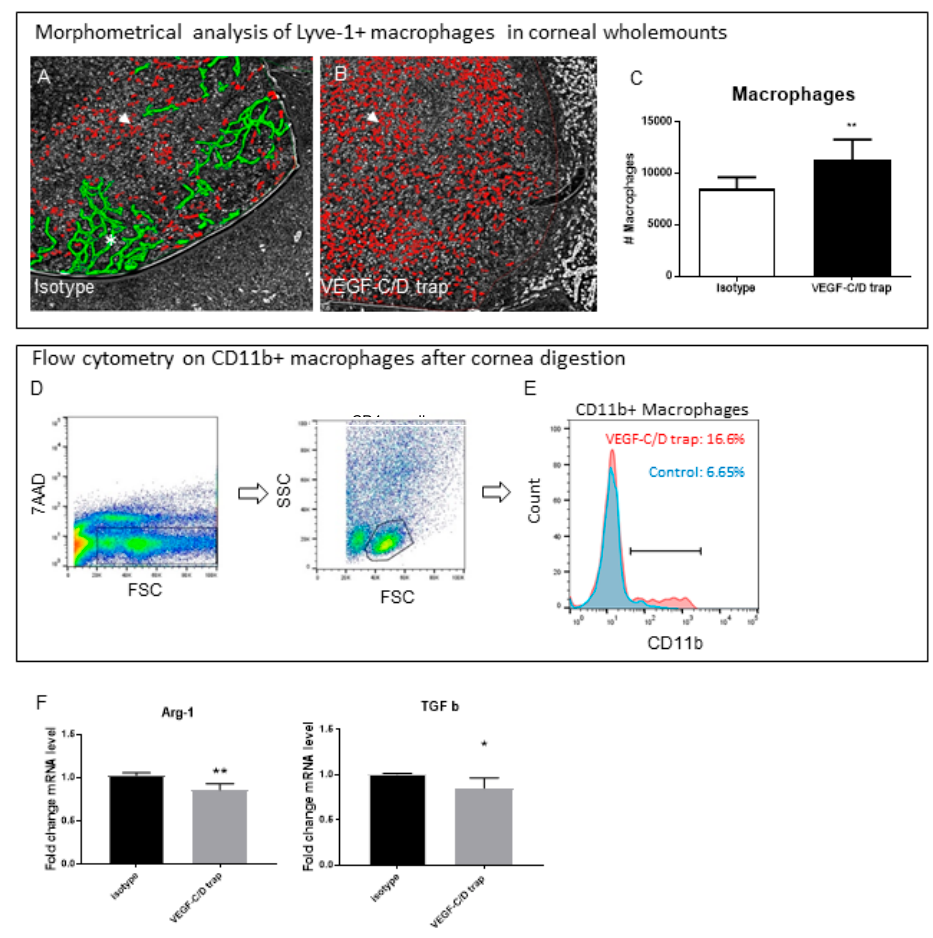
Figure 3. ( A , B ) representative images of corneal flatmounts stained with LYVE-1 and quantified by threshold analyses (red, arrowhead: macrophages, quantified; green, asterisk: lymphatic vessels, not quantified); ( C ) morphometrical analysis of Lyve-1 + macrophages in VEGF-C / D Trap treated vs control treated inflamed corneas (n = 10); ( D ) gating strategy: isolated cells where gated for live cells (7AAD-); lymphocyte population was identified by forward / sideward scatter plot of CD45 + cells; ( E ) Flow cytometry histogram of CD11b + macrophages in VEGF-C / D trap treated corneas (red, 16.6%) in comparison to isotype control (blue, 6.6%) (representative data from 2 independent experiments; pool of 7 corneas / group); ( F ) qPCR analysis on the expression of Arginase-1 (Arg-1) and TGF- β (TGF b) in inflamed corneas treated with VEGF-C / D trap in comparison to isotype control (n = 12, in pools of 3). (* p = 0.05, ** p = 0.001)